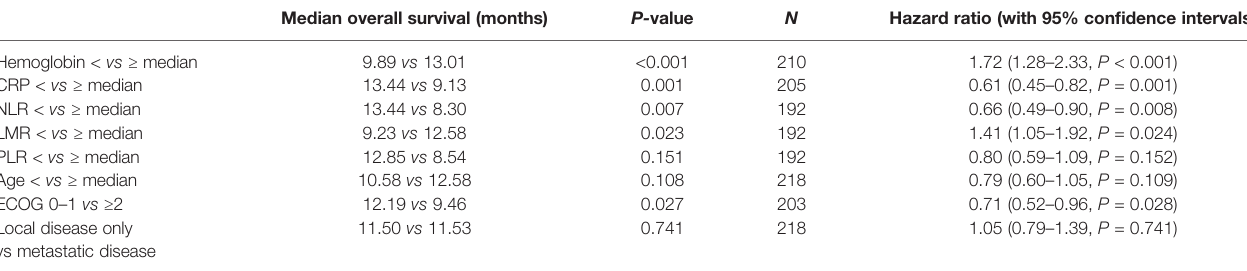
TABLE 5 | Median overall survival from start of fi rst-line therapy and hazard ratio (univariate analysis).